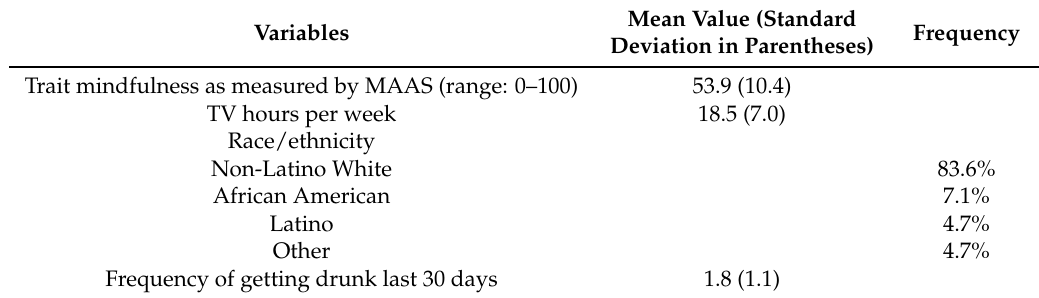
Table 1. Descriptive statistics of 286 male freshmen from Clemson